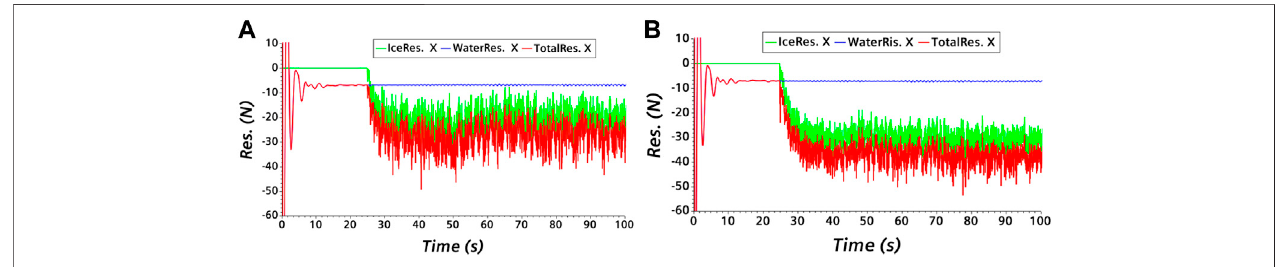
FIGURE 12 | Time histories of resistance.